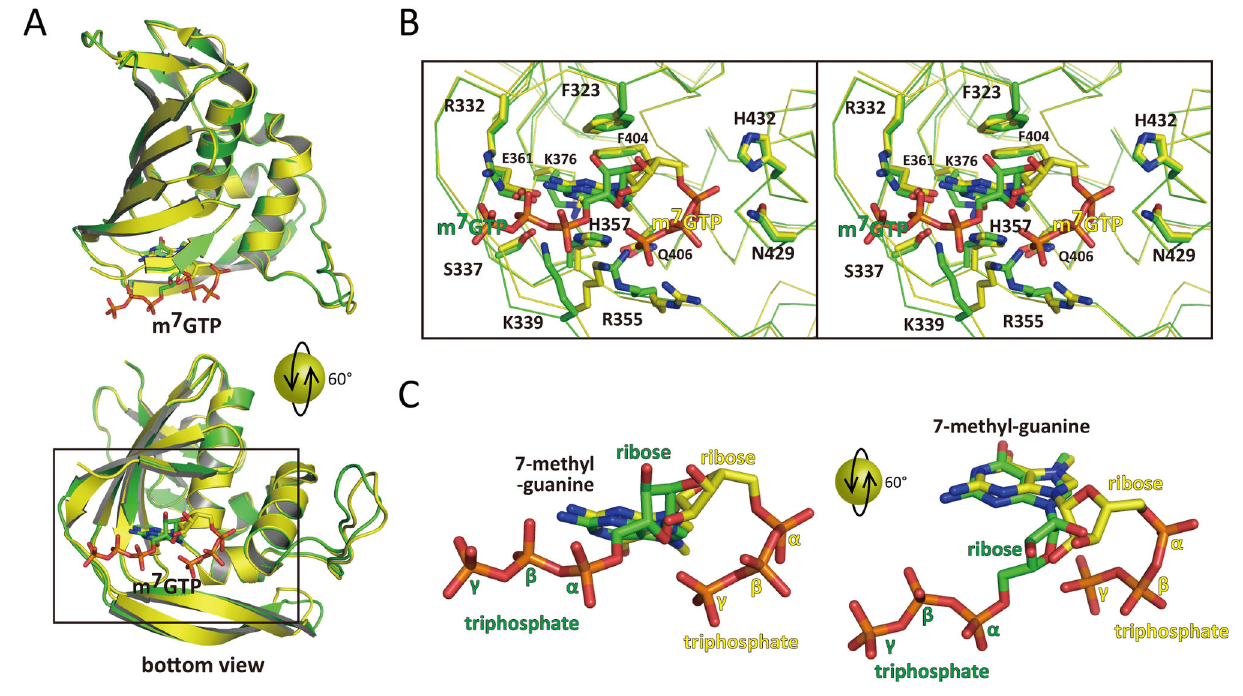
Figure 3. Comparison the m 7 GTP-bound form in H1N1 (this report) and H3N2 (2VQZ). A) Crystal structure in H1N1 and H3N2 are shown in green and yellow, respectively. Both m 7 GTPs are depicted with stick model. Upper panel is the overall structure and lower panel is the bottom view with 60° orientation of upper panel. B) Close-up view of the square of panel A in stereo view. Main chain is represented by ribbon. Active site residues are labeled in black. C) Comparison the conformation of m 7 GTP in H1N1 and H3N2 structure. Left panel is same orientation as A and B. Right panel is the same model as left panel but rotated by 60° about a horizontal axis to show the active site.. The position of ribose and triphosphate are labeled in each color. The 7-methyl guanine is same conformation and it is labeled in